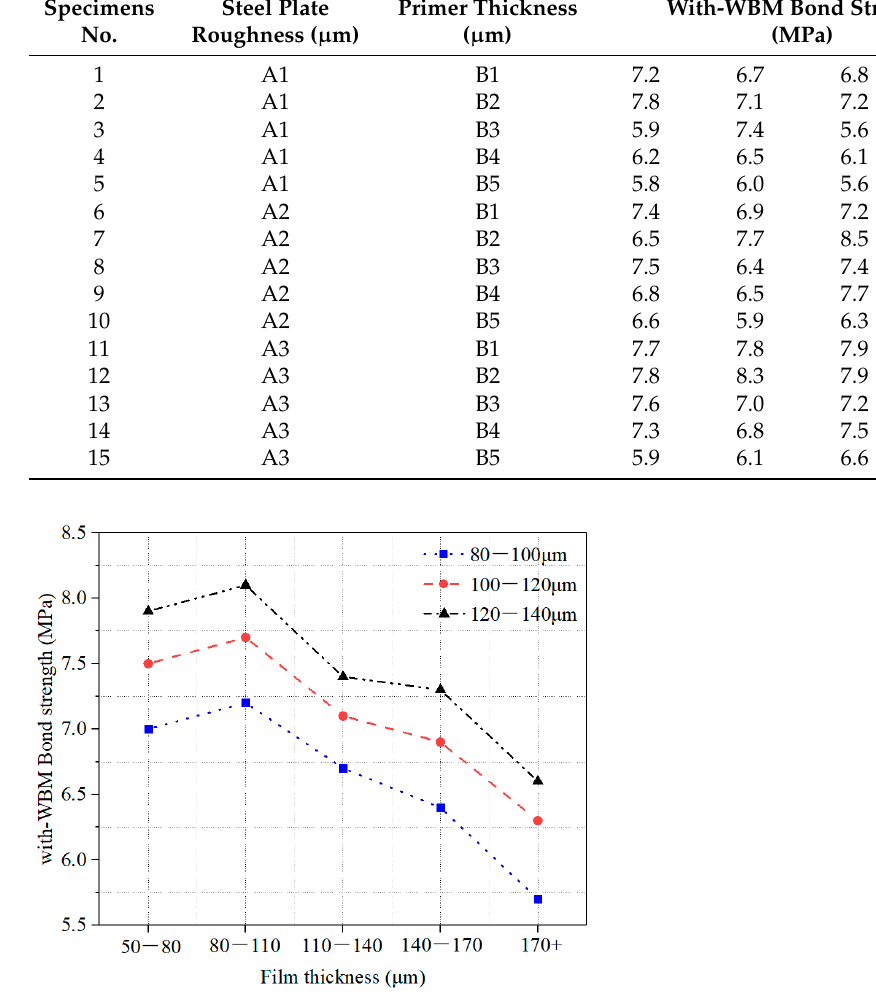
Figure 18. Influences of the steel plate roughness and zinc-rich epoxy primer thickness on the with-WBM bond strength.